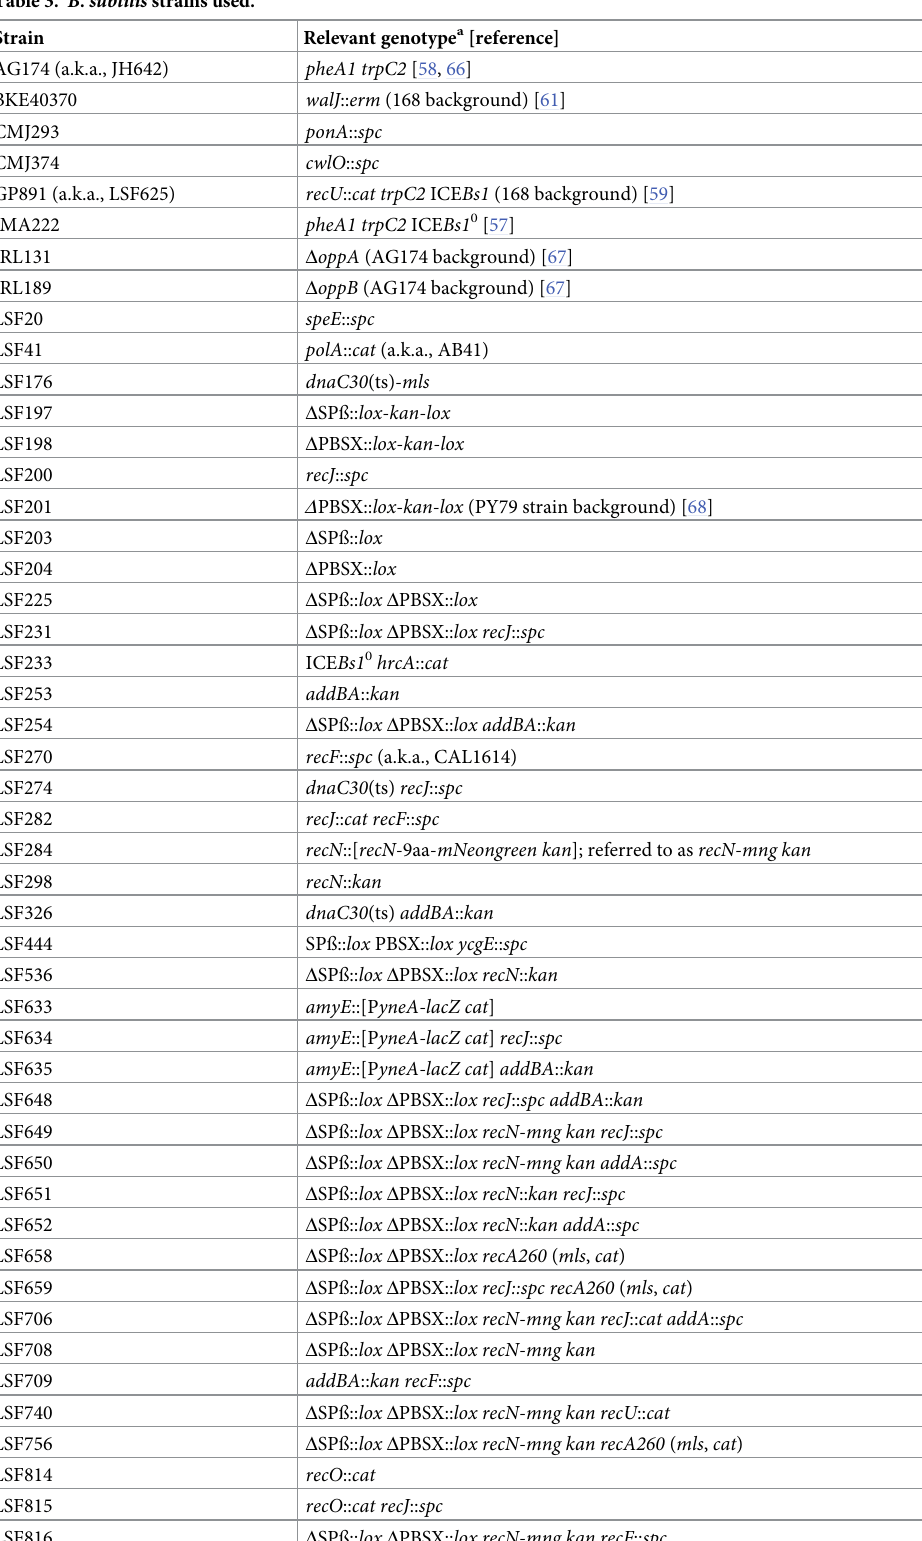
Table 3. B . subtilis strains used. Strain Relevant genotype a